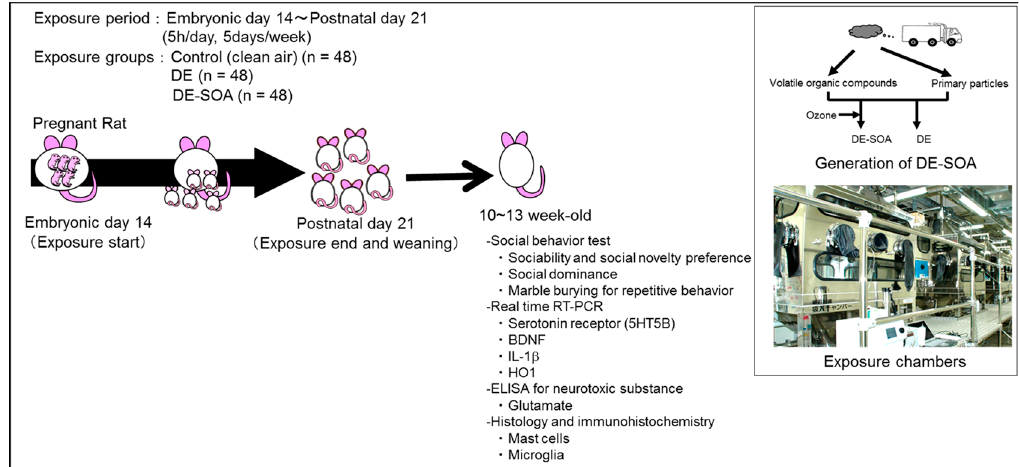
Figure 7. Experimental protocol including generation of DE-SOA and exposure chambers. Forty-eight timed pregnant Sprague–Dawley rats were exposed to clean air (control, n = 48), DE ( n = 48), or DE-SOA ( n = 48) from gestational day (GD) 14 to postnatal day (PND) 21 in the whole-body exposure chambers. Sixteen male and female offspring from the control, DE, and DE-SOA groups were used for social behavioral tests at 10~13 weeks old. After completing the social behavioral test, brain samples were collected for molecular analyses.